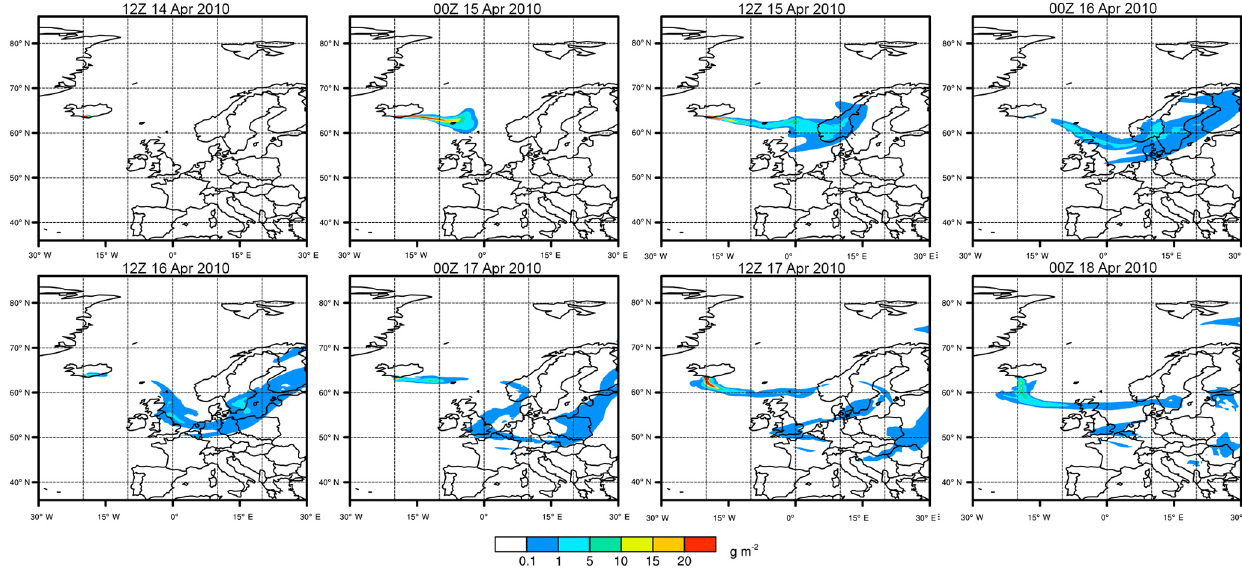
Figure 6. NMMB-MONARCH-ASH total ACL (mass loading; gm − 2 ) for the 2010 Eyjafjallajökull application.